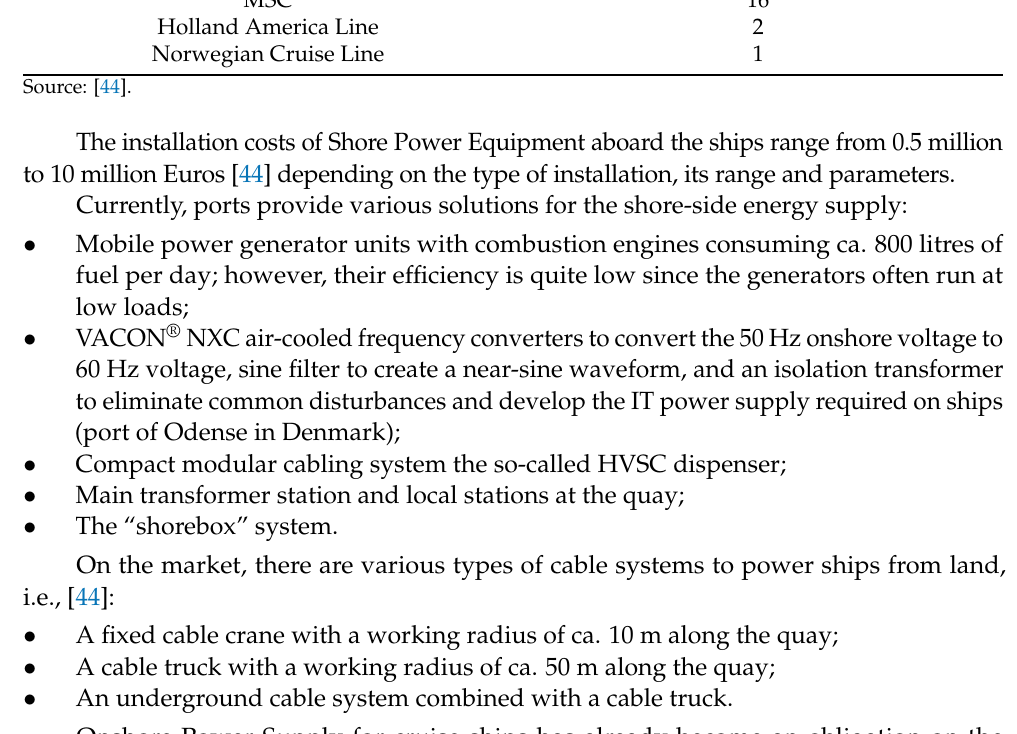
Table 1. Shore Power Equipment on cruise ships of leading cruise shipping organizations. Name of a Cruise Corporation Number of Cruise Ships with SPE Royal Caribbean Carnival Group (Carnival, P&O and Cunard)